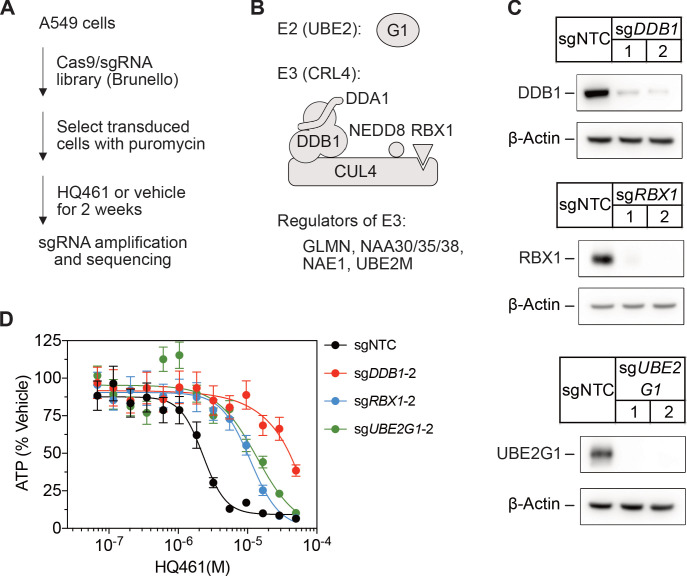
CRISPR-Cas9 screening for HQ461 resistance.(A) Genome-wide CRISPR-Cas9 screening procedures. (B) Classification of top-ranking genes into functional categories in the ubiquitin-proteasome system. (C) Verification of successful depletion of DDB1, RBX1, and UBE2G1 by individual sgRNAs. (D) Measurement of the HQ461 IC50 on the viability of A549 cells expressing sgRNAs targeting DDB1 (IC50 >28.8 µM), RBX1 (IC50 = 11.0 µM, 95% CI: 9.1 µM-14.2 µM), or UBE2G1 (IC50 = 13.6 µM, 95% CI: 5.0 µM-50 µM) that are independent of the sgRNAs used for the experiments presented in Figure 1D. Error bars represent SEM from three biological replicates.